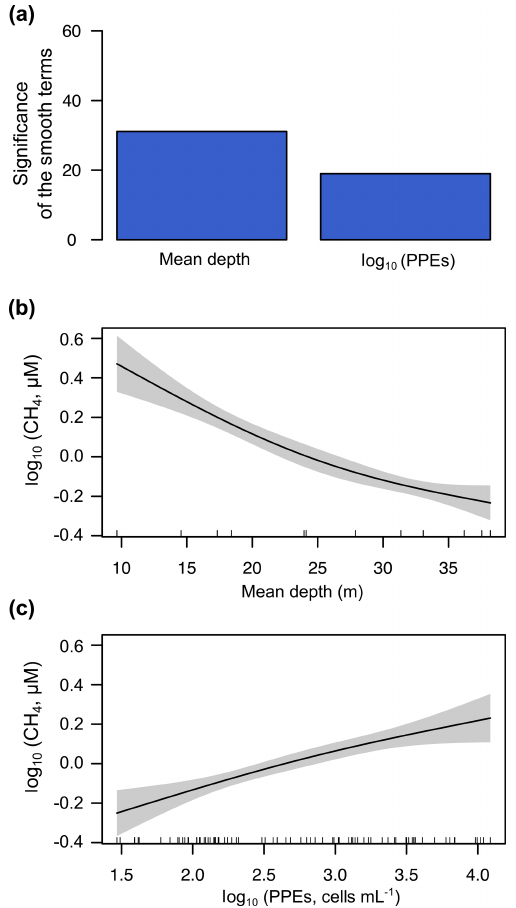
Figure 10. Results of the generalized additive model (GAM) fitted for the concentrations of CH 4 in the oxic waters during the mix- ing period. (a) Bar plot showing the significance of the smooth terms from the fitted GAM ( F values). Panels (b) and (c) show partial response plots from the fitted GAM, showing the additive effects of the covariates on the dissolved CH 4 concentration: the mean depth (b) and the abundance of photosynthetic picoeukary- otes (log 10 PPEs) (c) . In partial response plots, the lines are the smoothing functions, and the shaded areas represent 95% point- wise confidence intervals. Rugs on x axis indicate the distribution of the data. More details are provided in Table